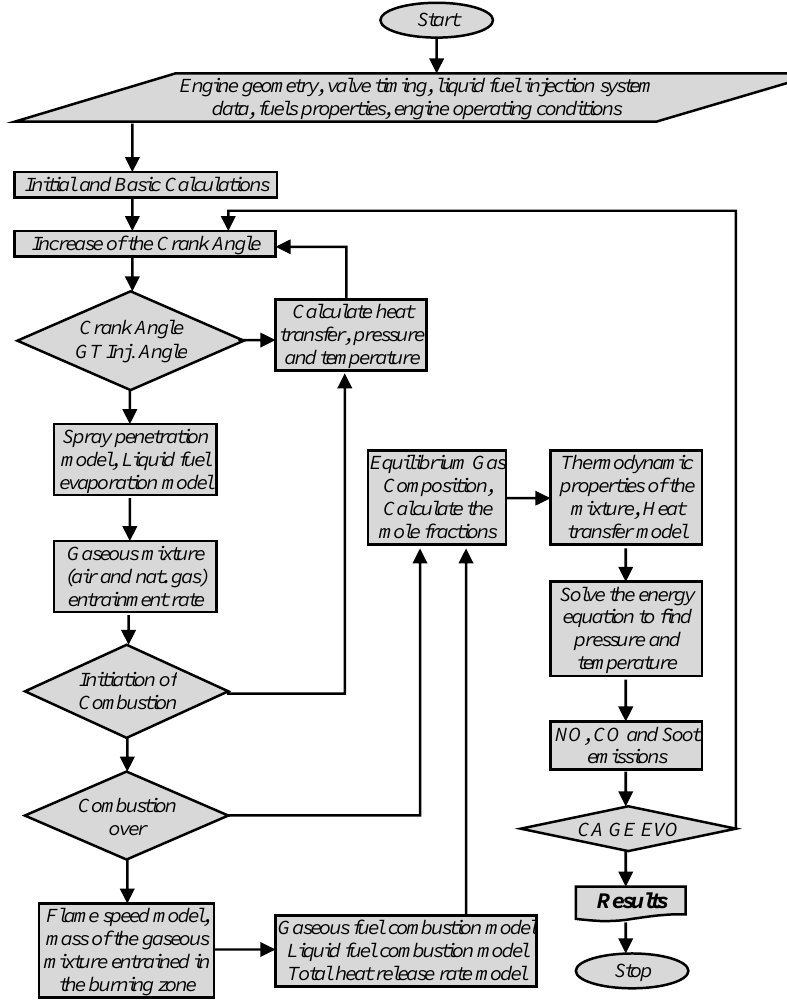
Figure 1. Flow chart diagram of the simulation model.